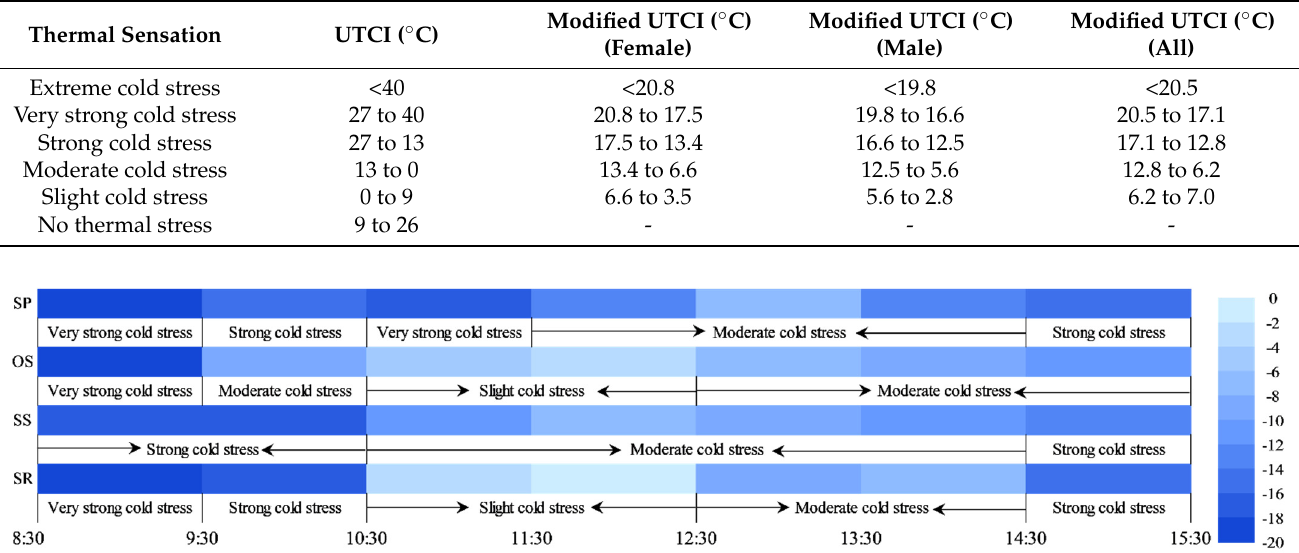
Figure 10. Daytime heat stress in the four open spaces in winter.